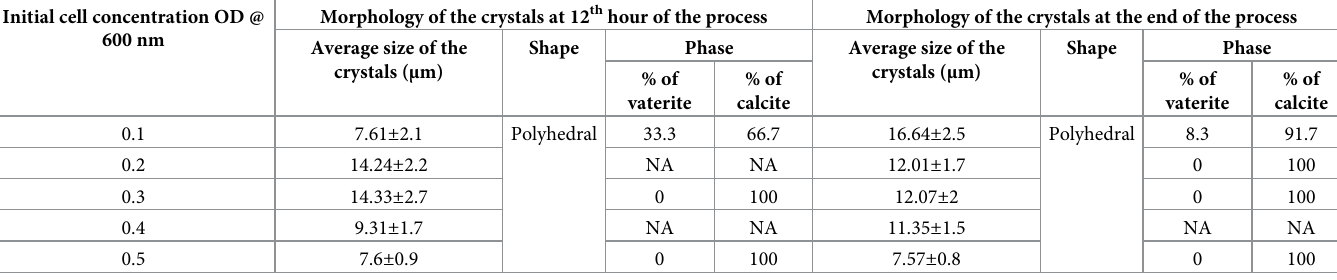
Table 5. Morphological and phase observation of calcium carbonate precipitate in medium inoculated with 0.1 OD to 0.5 OD of